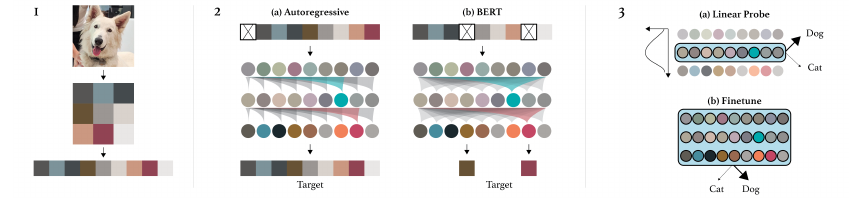
Figure 15. Image GPT Architecture.